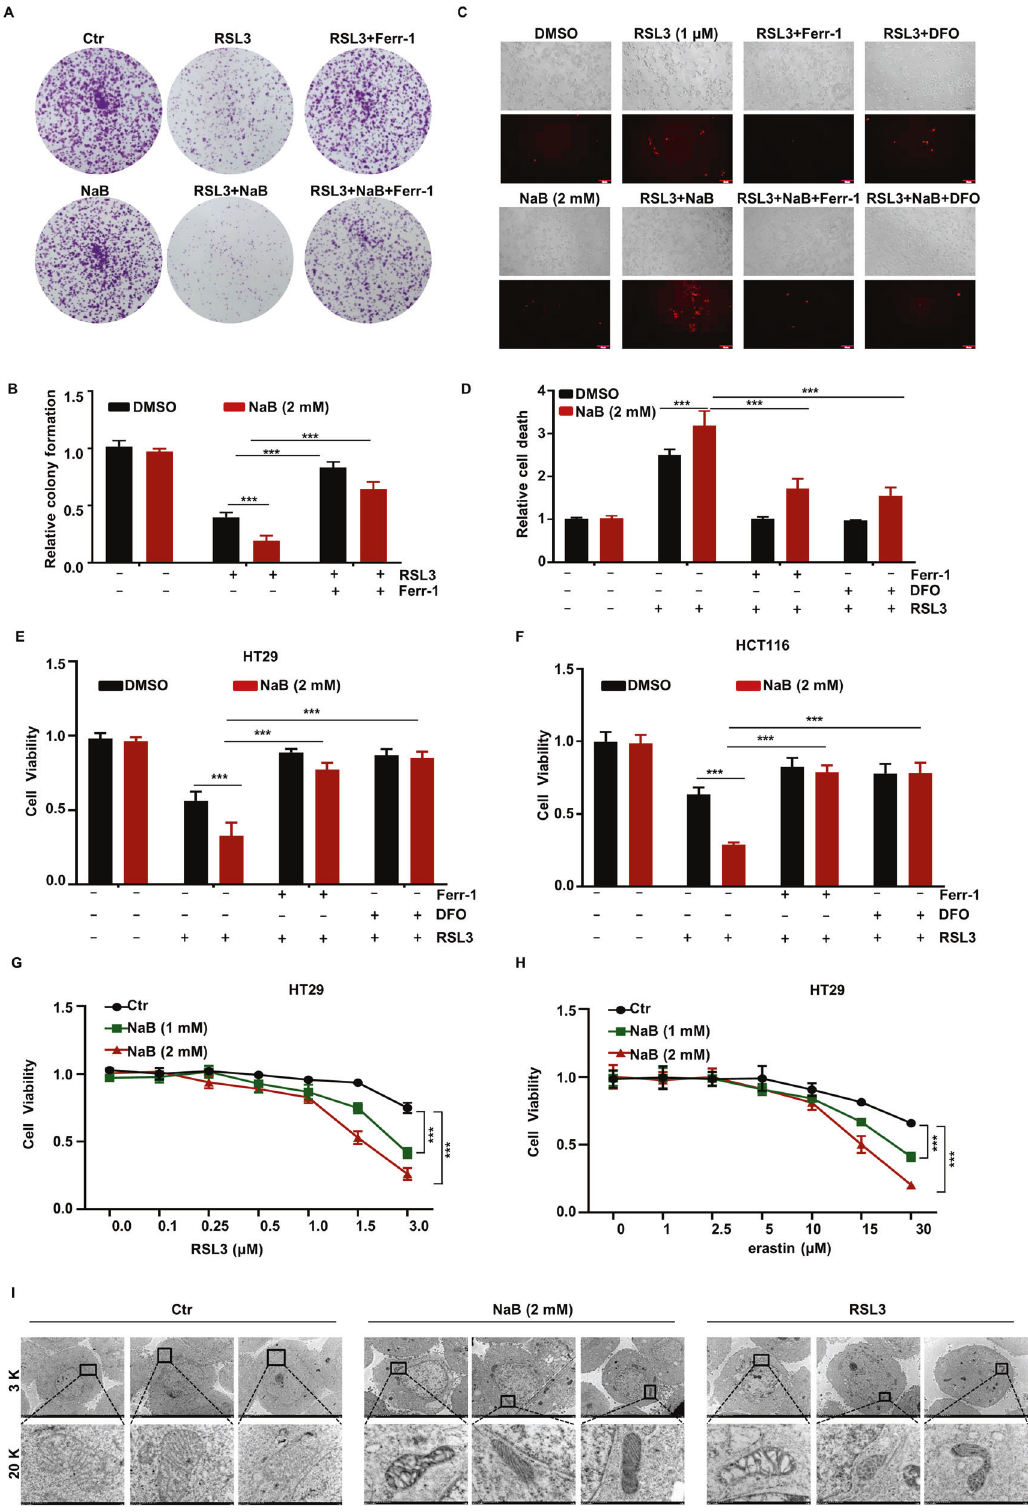
Fig. 1 Induction of cell death by butyrate in the presence of ferroptosis inducers. HT29 cells were treated with NaB (2 mM) for 24 h in combination with RSL3 (1 μ M) or Ferr-1 (5 μ M), after which cell viability was detected by colony formation assay ( A ) and the quantitative data is presented ( B ). HT29 cells were treated with NaB (2 mM) for 24 h in combination with RSL3 (1 μ M), Ferr-1 (5 μ M), or DFO (100 μ M) after which cell viability was detected by dead cell staining assay ( C ) and the quantitative data is presented ( D ). HT29 ( E ) or HCT116 ( F ) cells were treated with RSL3 (1 μ M) for 6 h in combination with NaB (2 mM), Ferr-1 (5 μ M) or DFO (100 μ M), and the viability of indicated cells was examined using CCK-8. HT29 cells were treated with different concentrations of RSL3 for 6 h ( G ) or erastin for 20 h ( H ) in combination with indicated concentrations of NaB, and the cells viability was examined using CCK-8. I HT29 cells were treated with the RSL3 (1 μ M) or NaB (2 mM) for 24 h, and analyze the ultrastructure of mitochondria with transmission electron microscopy. Cell Death and Disease (2023)